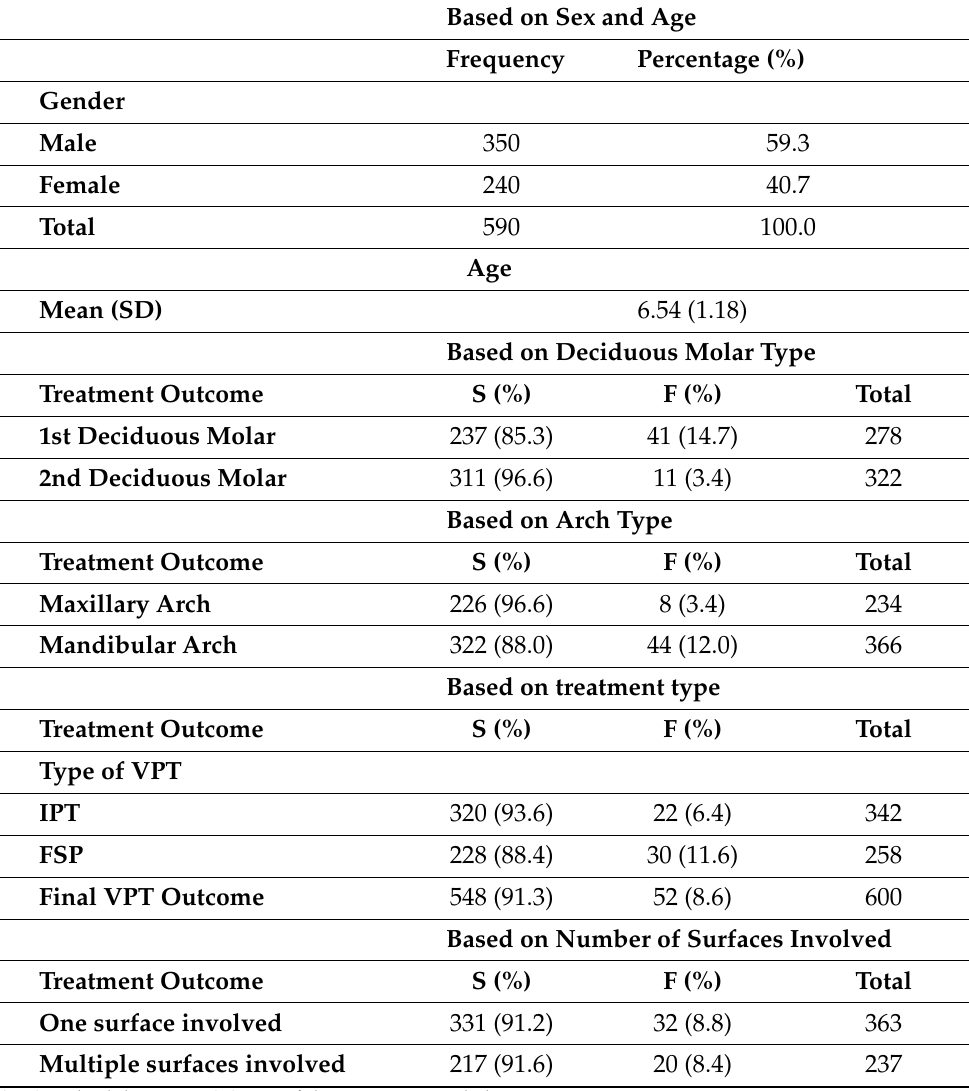
Table 2. Univariate logistic regression model showing the odds ratio (OR) (95% confidence interval (CI)) for successful treatment outcomes according to all clinically observed variables.